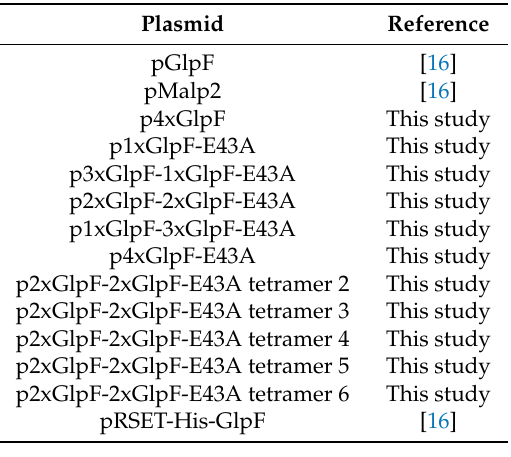
Table 1. Plasmids used in this study. All plasmids carry an ampicillin resistance